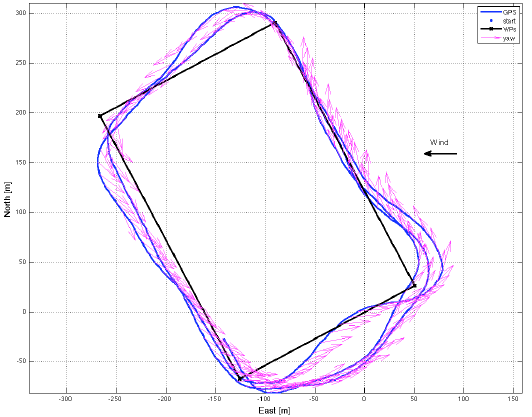
Figure 7: Closed-loop path tracking performance under moderate (8kt) easterly winds. For this mission, the waypoints were defined as the corners of the black